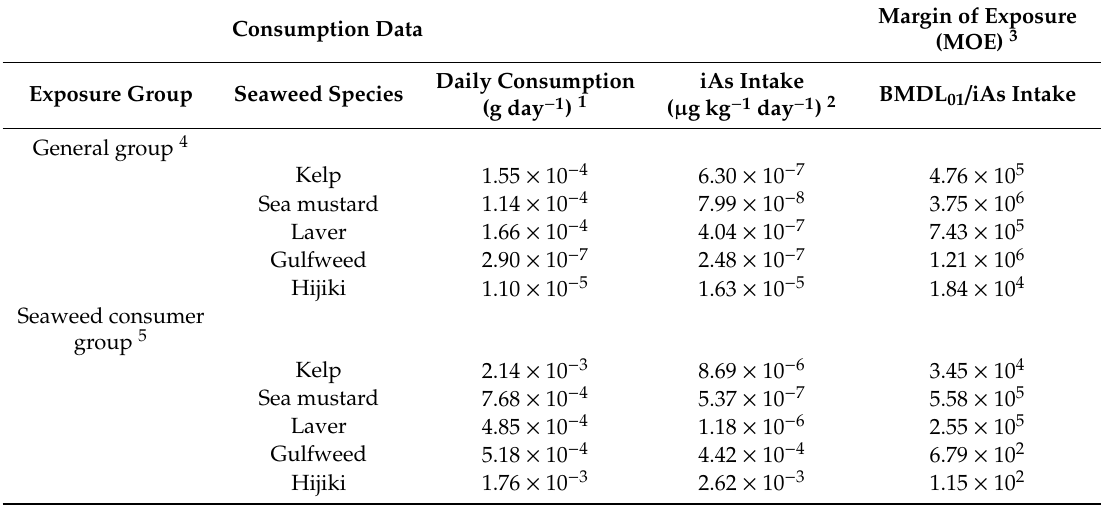
Table 4. Daily intake of seaweed and dietary exposure of arsenic through seaweed ingestion. Consumption